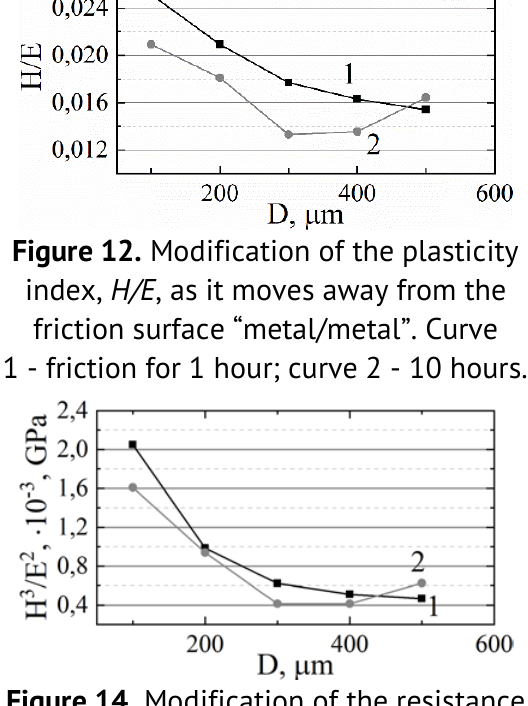
Figure 14. Modification of the resistance index, H 3 /E 2 , as it moves away from the friction surface “metal/metal”. Curve 1 - friction for 1 hour; curve 2 - 10 hours.